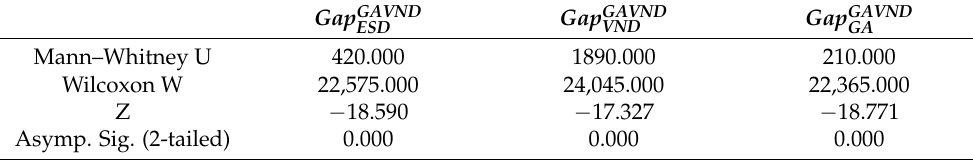
Table 6. Test Statistics in the Wilcoxon Rank Sum Test a